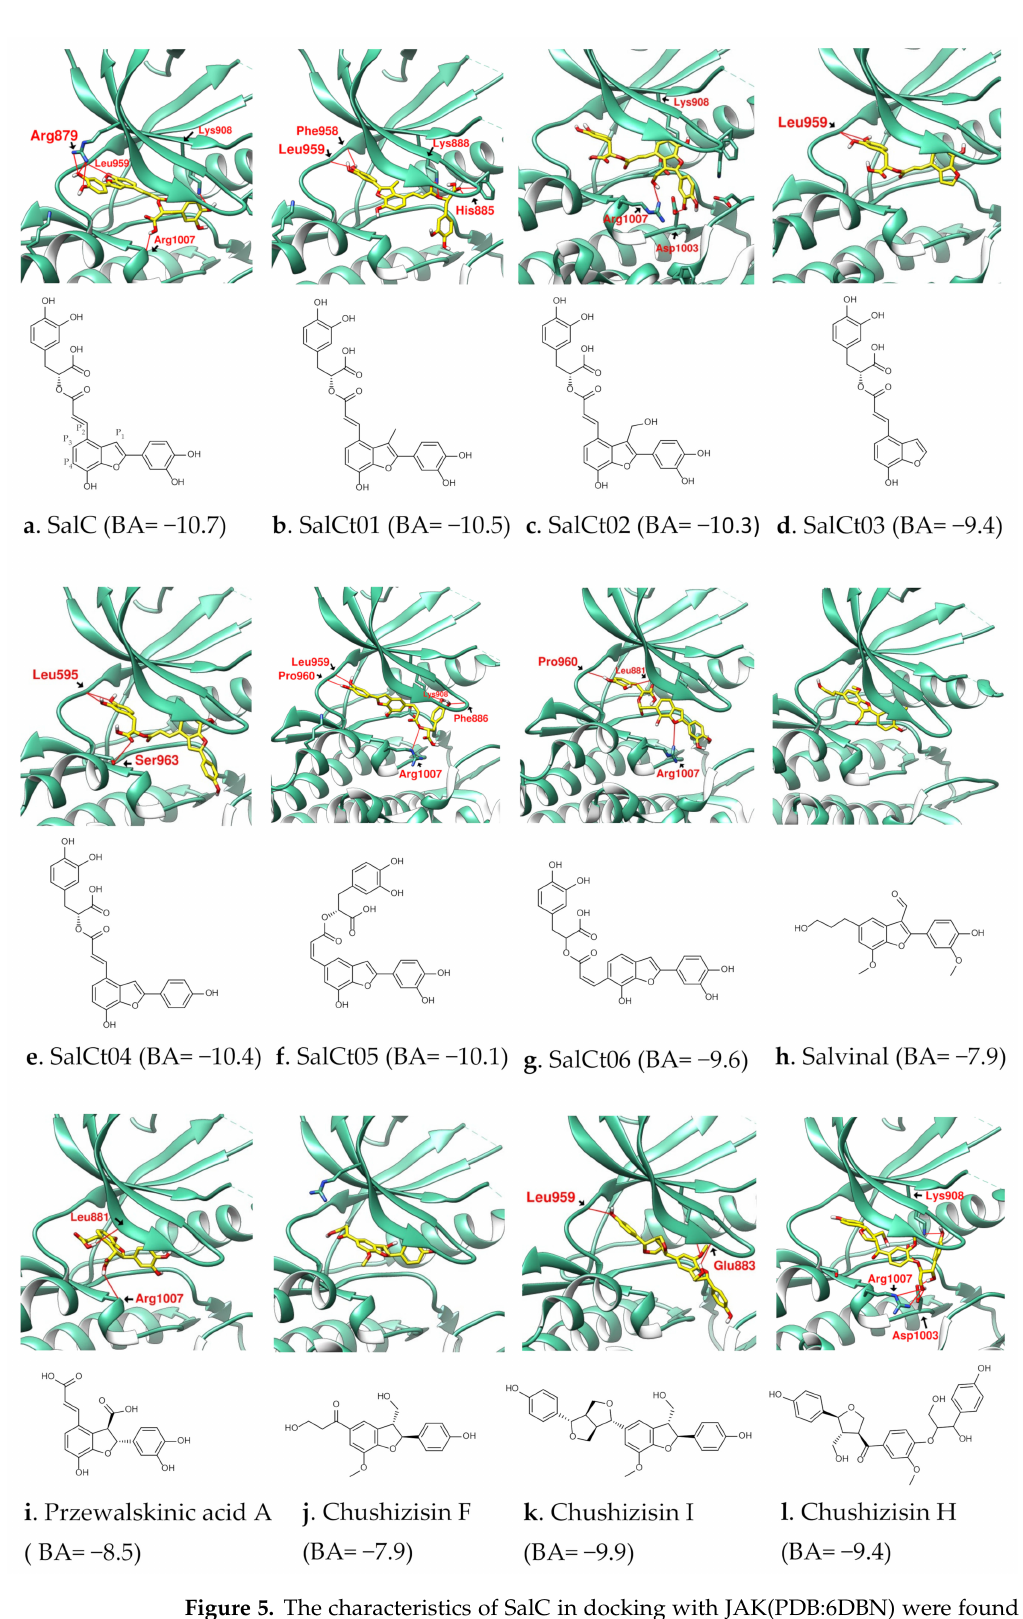
Figure 5. The characteristics of SalC in docking with JAK(PDB:6DBN) were found by comparing SalCt01~SalCt06. ( a ) SalC with encoding. The benzofurans of the compounds ( b – k ) showed different positions from SalC in the docking. ( l ) is the ring-opened form of ( k ). The location of SalC’s benzofuran brings benefits to its binding affinity. Hydrogen bonds were shown as red lines with